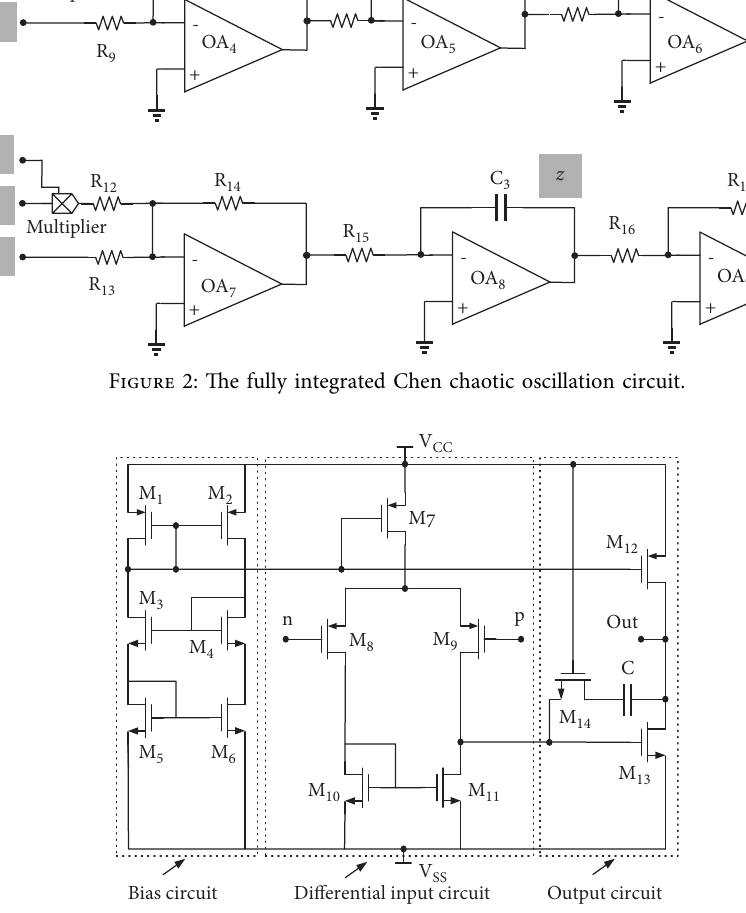
Figure 3: The designed OA.